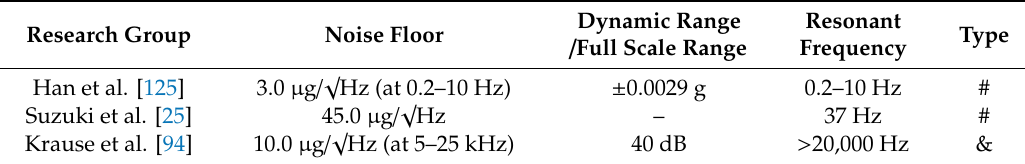
Table 4. Summary of micromachined accelerometers with more than µ g / √ to achieve a sub- µ g / Hz noise